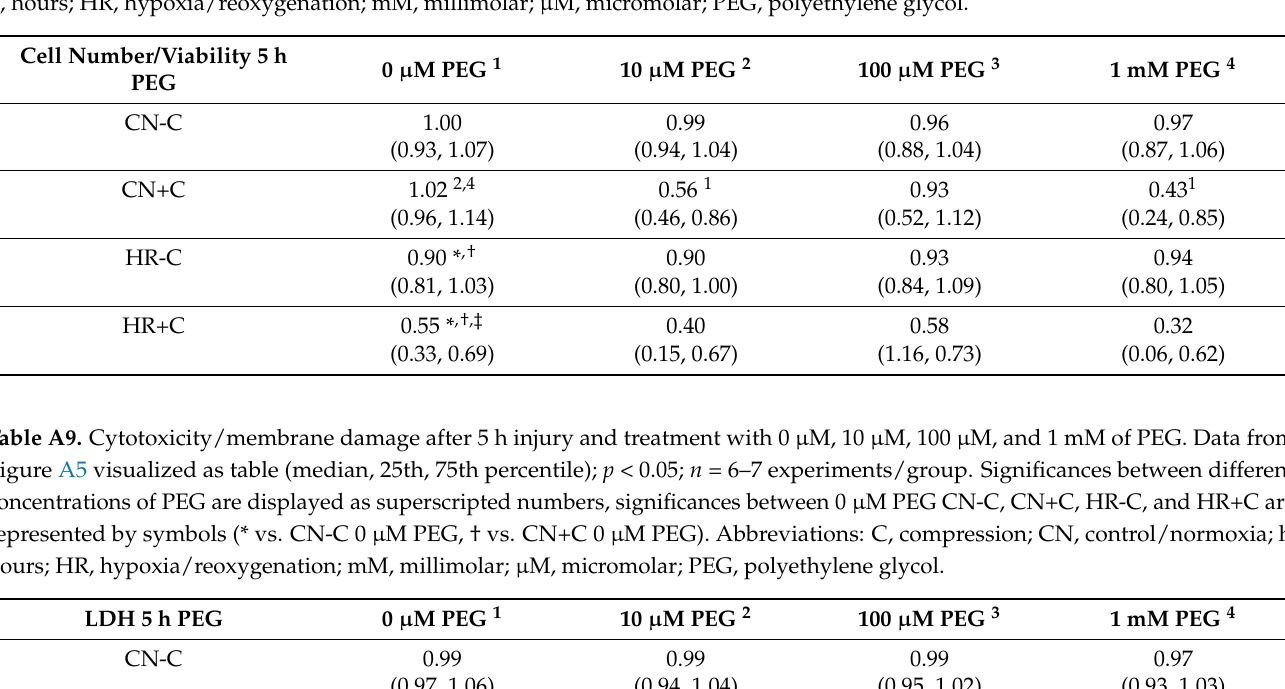
Table A8. Cell number/viability after 5 h injury and treatment with 0 µ M, 10 µ M, 100 µ M, and 1 mM of PEG. Data from Figure A4 visualized as table (median, 25th, 75th percentile); p < 0.05; n = 6–7 experiments/group. Significances between different concentrations of PEG are displayed as superscripted numbers, significances between 0 µ M PEG CN-C, CN+C, HR-C, and HR+C are represented by symbols (* vs. CN-C 0 µ M PEG, † vs. CN+C 0 µ M PEG, ‡ vs. HR-C 0 µ M PEG). Abbreviations: C, compression; CN, control/normoxia;